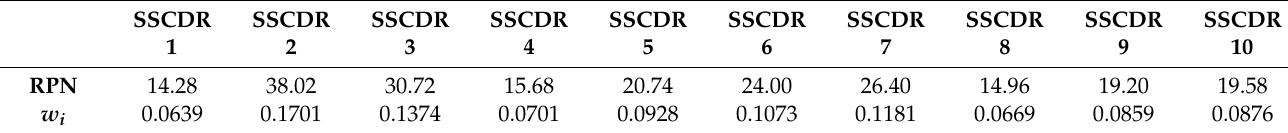
Table 10. Relative weights of SSCDRs after